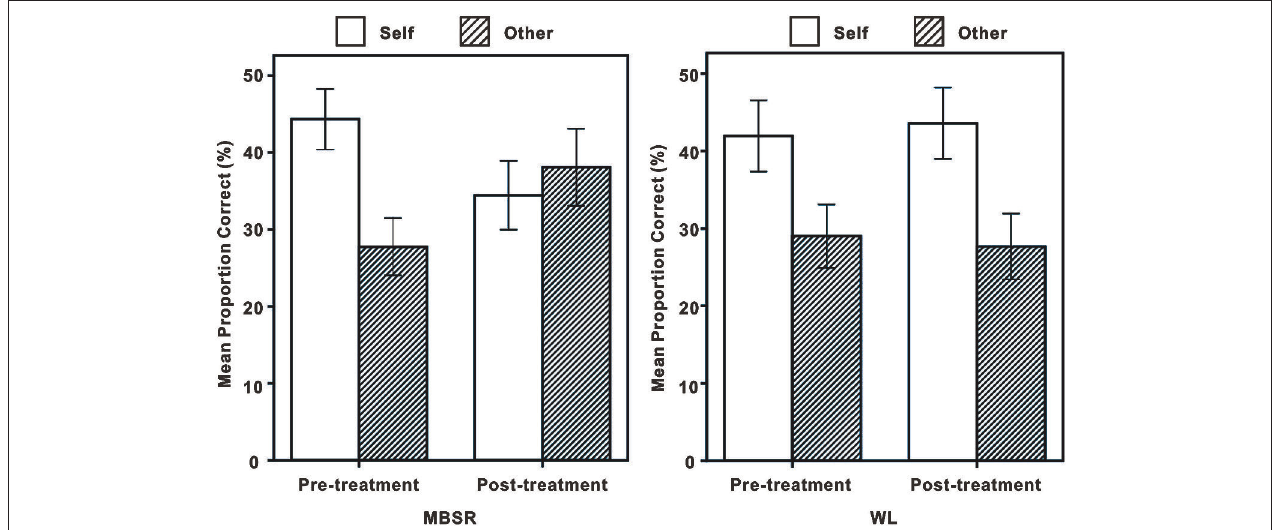
FIGURE 2 | Memory performance at Pretreatment vs. Post-treatment on self and other conditions for mindfulness-based stress reduction (MBSR) (left) and wait list (WL) (right). Error bars represent 95% confidence intervals.